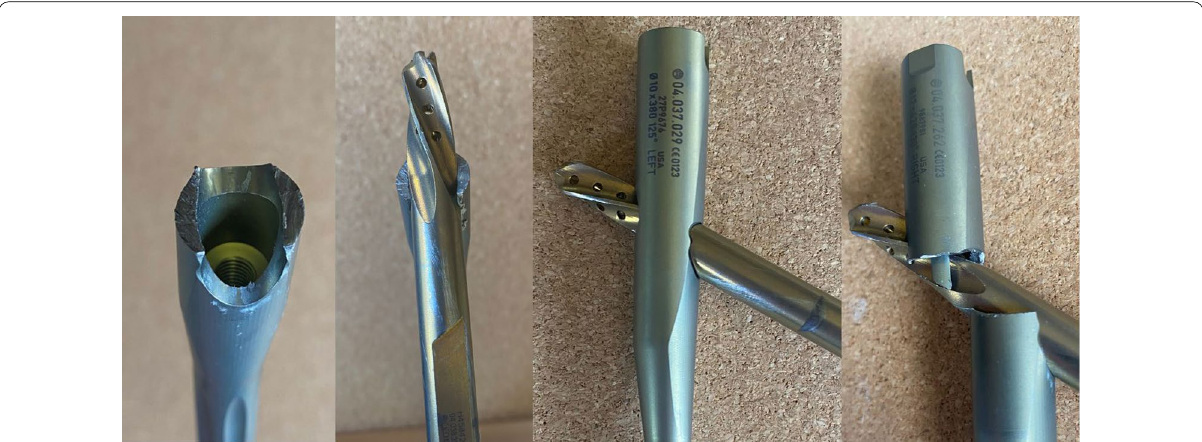
Fig. 6 Pictured from left to right: (1) Looking down at the lateral aspect of the lower half of a sectioned TFNa implant thru the proximal screw aperture. (2) The diameter of this sectioned proximal screw aperture is completely filled with insertion of the helical blade. (3) When the set screw is prematurely deployed, it acts as a mechanical block to the advancing helical blade. The blade is unable to advance any further than pictured without fracture of the locking prong. (4) Sectioned TFNa implant that has been displaced to show the direct contact of the helical blade against the locking prong when it has been deployed prior to blade/screw